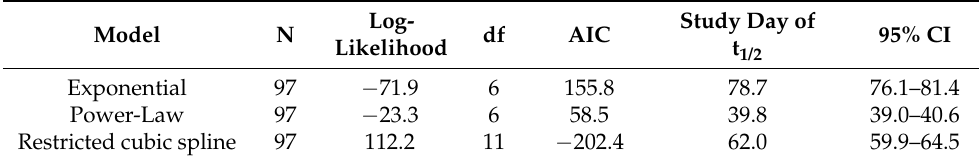
Table 3. Days required to halve anti-SARS-CoV-2 RBD IgG antibody levels after the first dose of the BNT162b2 compared to peak levels (i.e., at 30 days). Estimates from different models.